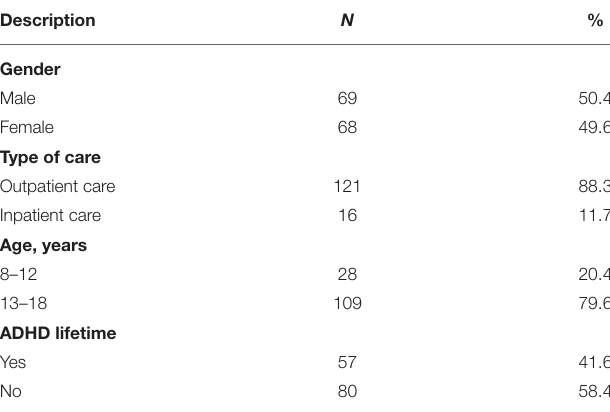
TABLE 1 | Descriptive statistics for CAP sample, n =